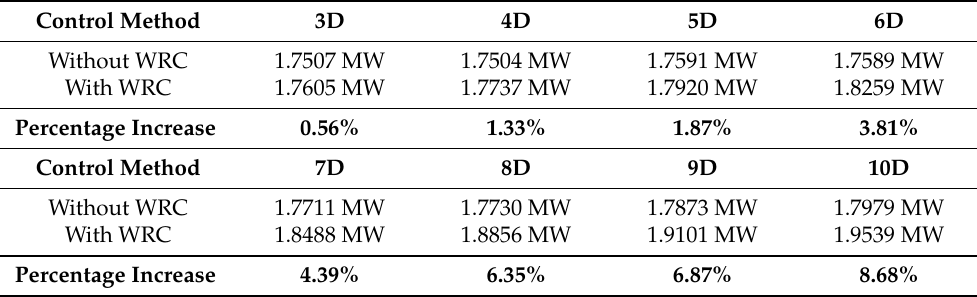
Table 1. Wind farm power for 3D to 10D spacing between the turbines. Control